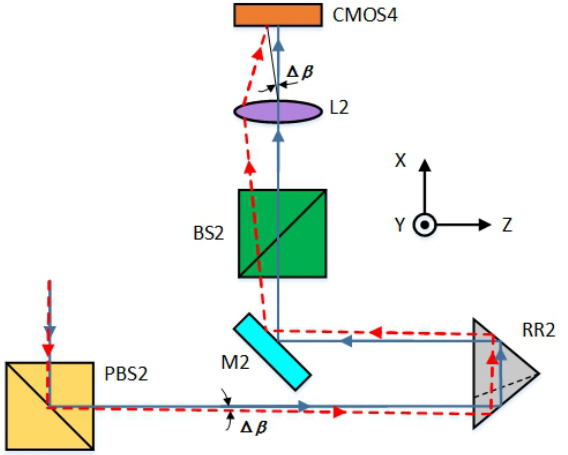
Figure 6. Measurement principle of the angular